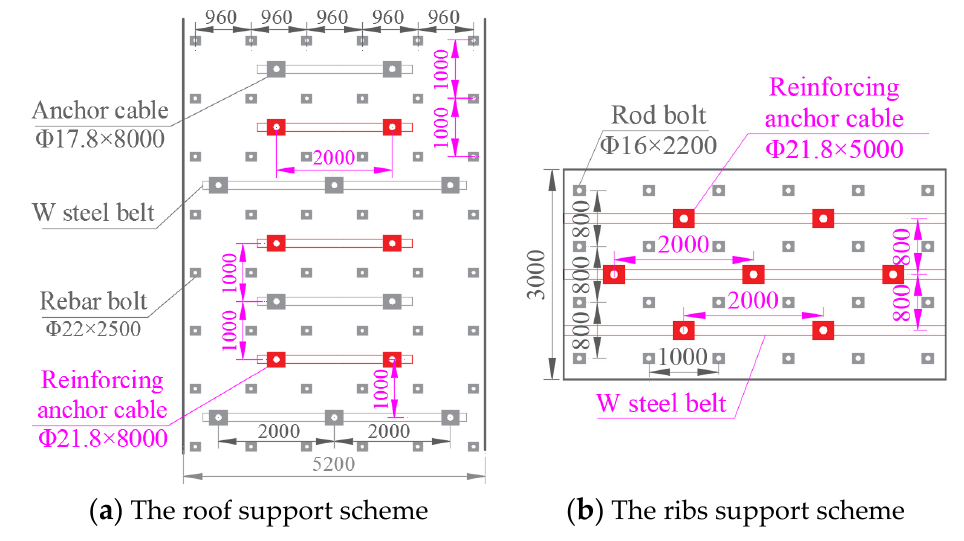
Figure 14. Reinforcement support scheme.